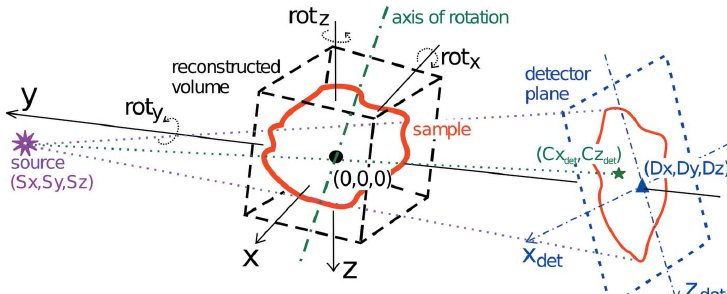
Figure 1 Reconstruction geometry. The center of origin is in the center of the reconstructed volume. Positions of the source and the detector are defined with respect to this point. Point ( C , C ) is the projection of the center of rotation on the detector x det z det plane. The detector, the rotation axis and the reconstructed volume can be arbitrarily